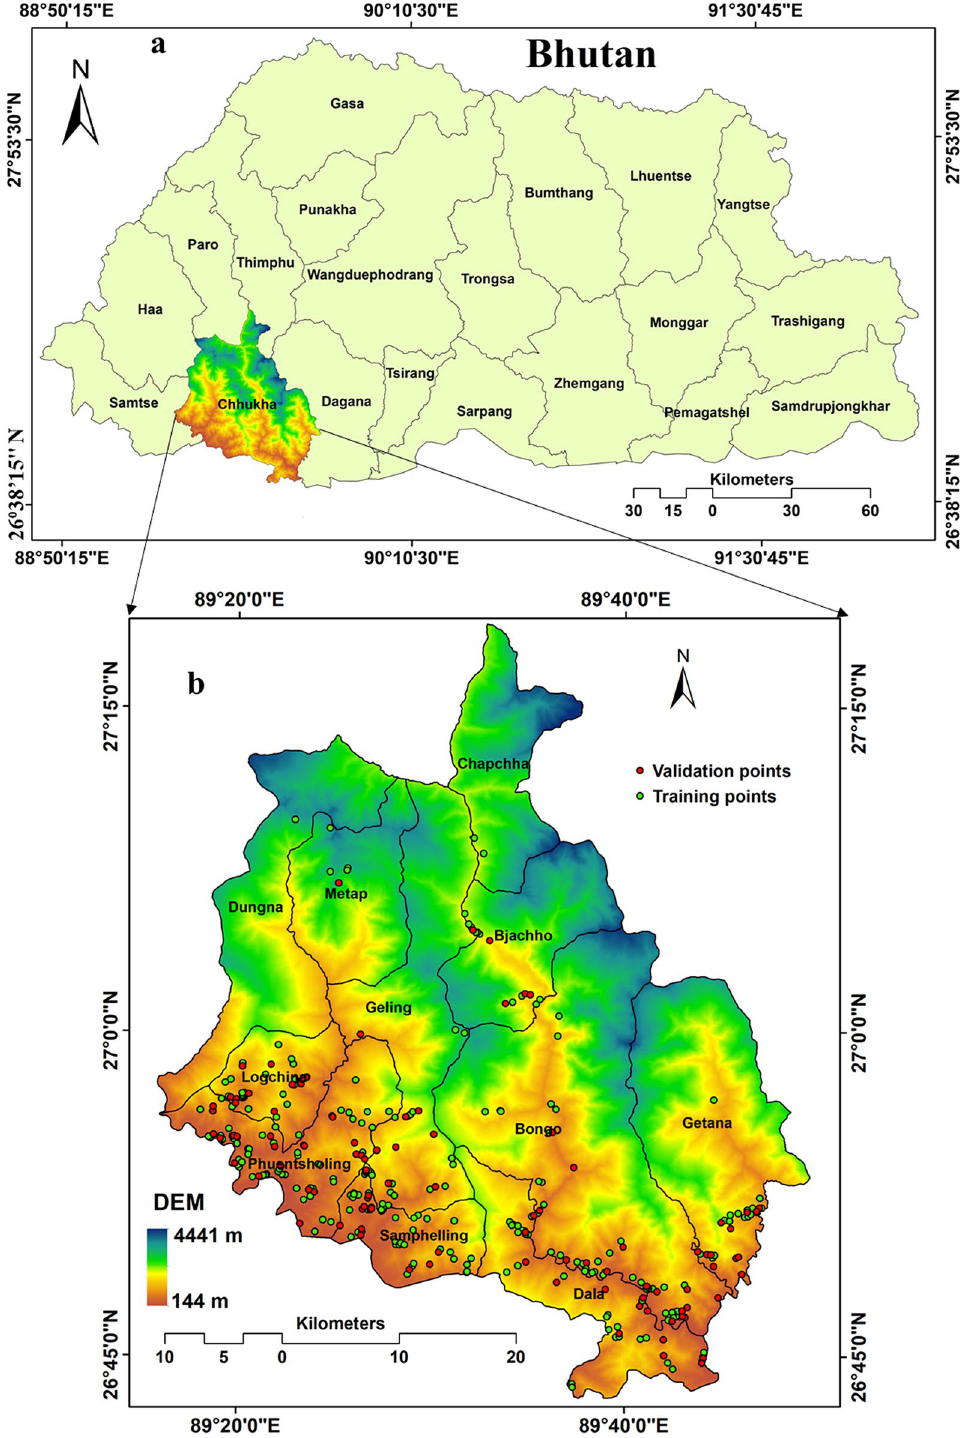
Figure 1. Location of the study area: ( a ) Bhutan and ( b ) Chukha district which is prepared by open source QGIS 3.16 software (https:// qgis. org/ en/ site/ forus ers/ downl oad.